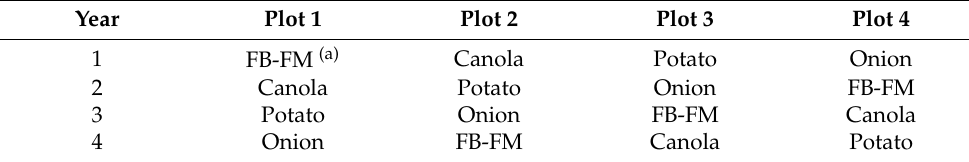
Table 2. The early-potato rotation designed, wherein potato returns to each plot every four